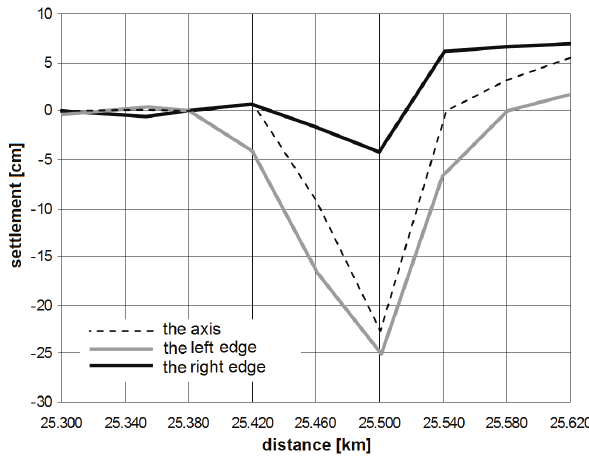
Figure 2: Measurement results of settlement of the embankment (in the axis, on the left and right edges of the